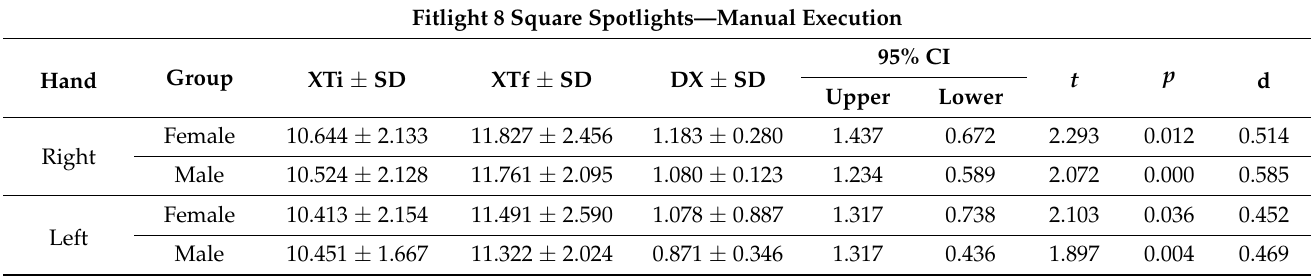
Table 3. Descriptive statistics of the Fitlight test 8 spotlights in a square—manual execution. Fitlight 8 Square Spotlights—Manual Execution